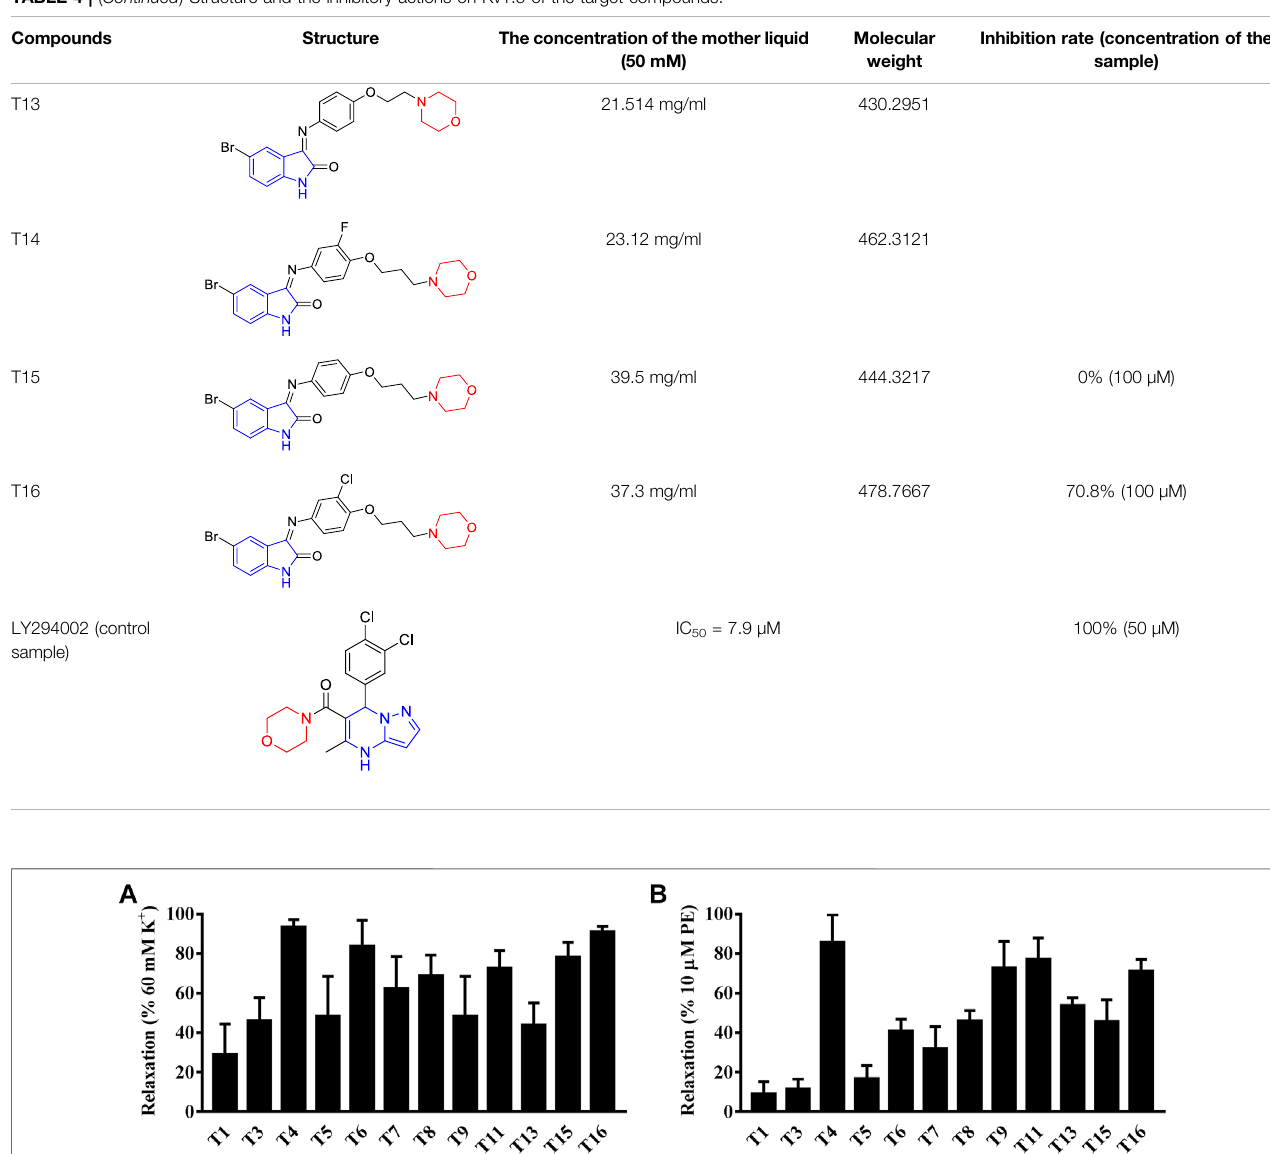
TABLE 4 | ( Continued ) Structure and the inhibitory actions on Kv1.5 of the target